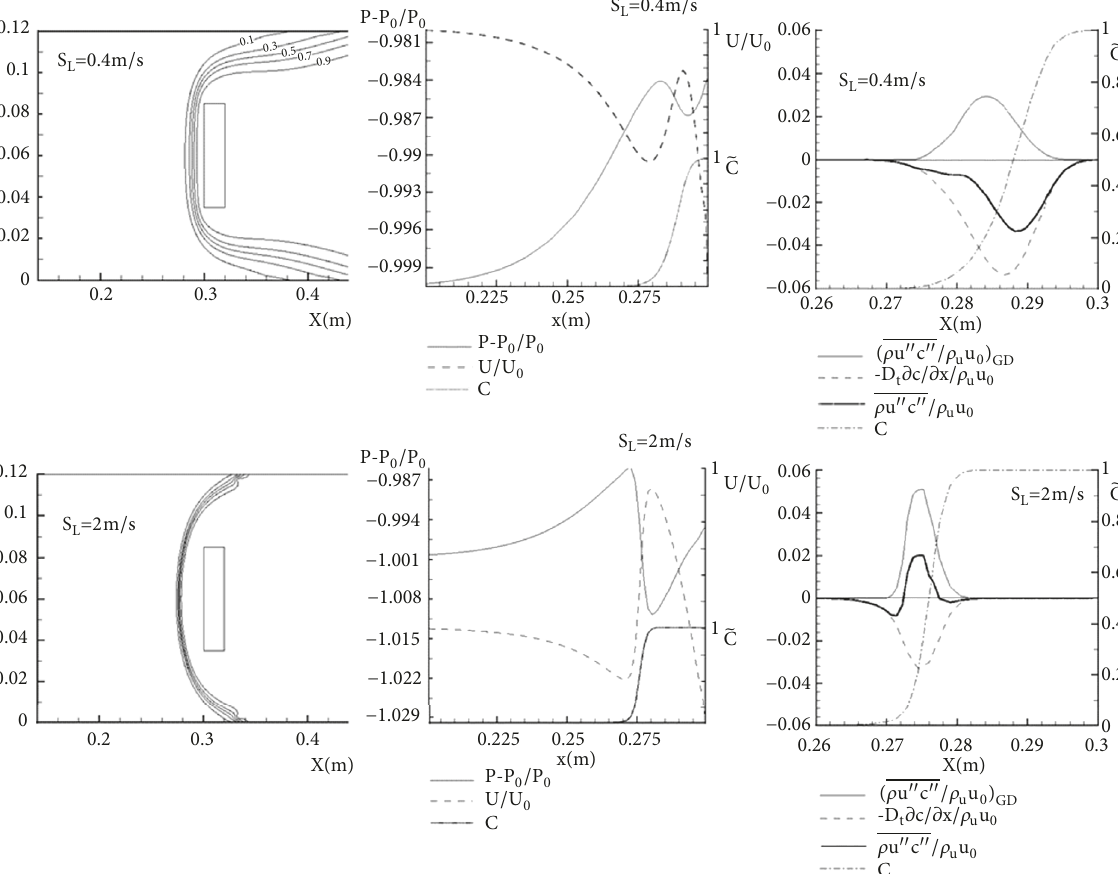
Figure 5: Configurations and profiles of the parameters of the flame close to the wall (upper plots) and the free-standing flame (lower